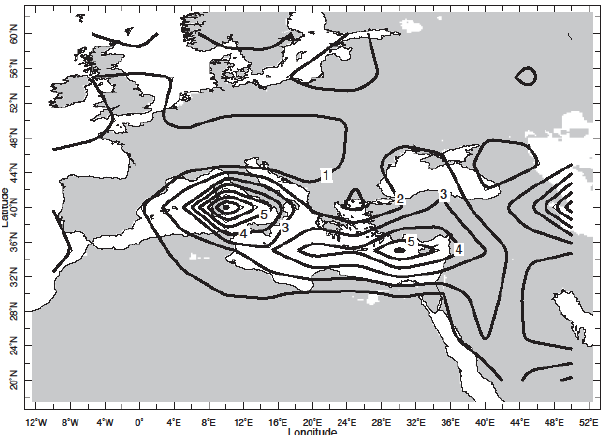
Fig. 2. Observed average number of wintertime (DJF) cyclones in a 5 ◦ × 5 ◦ grid boxes (in counts per box per year, in 1.0 interval) derived from the NCEP-NCAR Reanalysis daily averaged sea level pressure fields from 38 winters between 1961/1962 and 1998/1999.